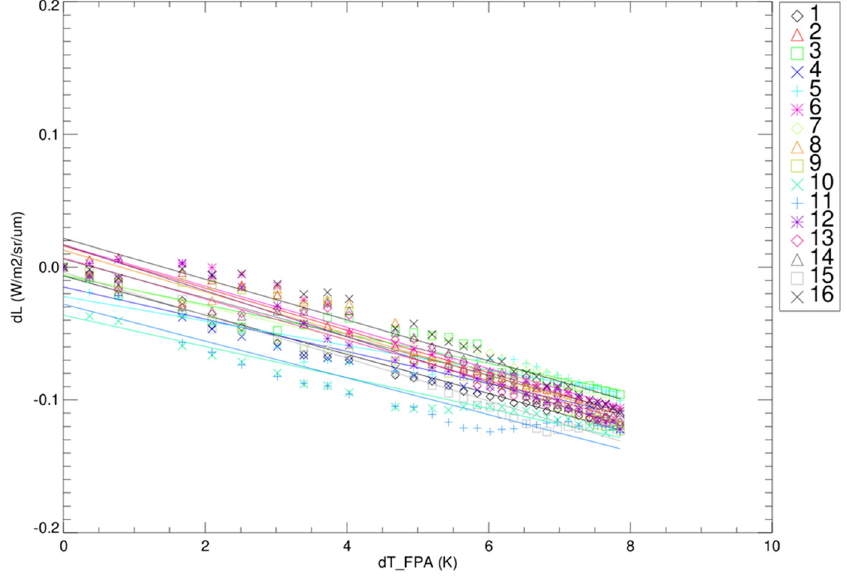
Figure 21. Band M1 temperature sensitivity (dL) as a function of focal plane assembly (FPA) temperature change between nominal and hot plateau for each detector (colors and symbols).